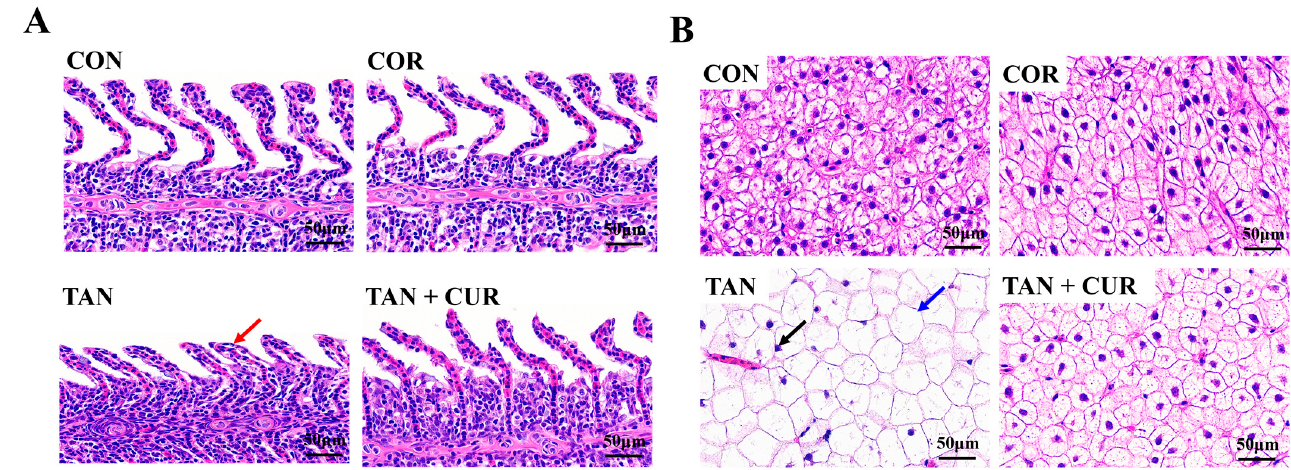
Figure 3. After feeding CUR diets for eight weeks, the histopathological damage caused by acute ammonia stress to gibel carp was improved. ( A ) Histological images of gills in gibel carp. ( B ) Histological images of liver in gibel carp (red arrows indicate atrophy of gill lamellae; black arrows indicate nucleus deviation; blue arrows indicate swelling of hepatocytes as well as vacuolization).